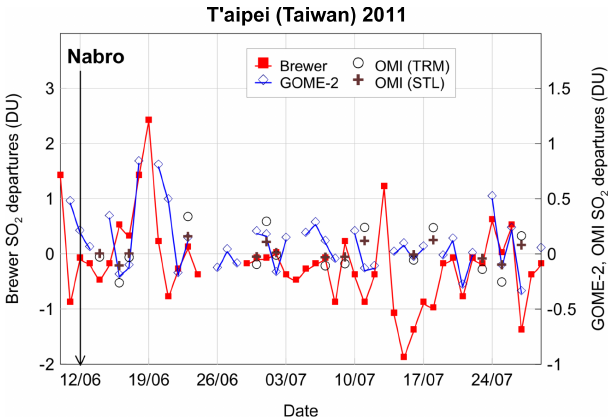
Figure 9. SO 2 column departures from the unperturbed 10-day pre-volcanic baseline measured by Brewer, OMI (TRM, STL) and GOME-2 over T’aipei, Taiwan, during June–July 2011 following the 2011 Nabro volcanic eruption (on 12 June